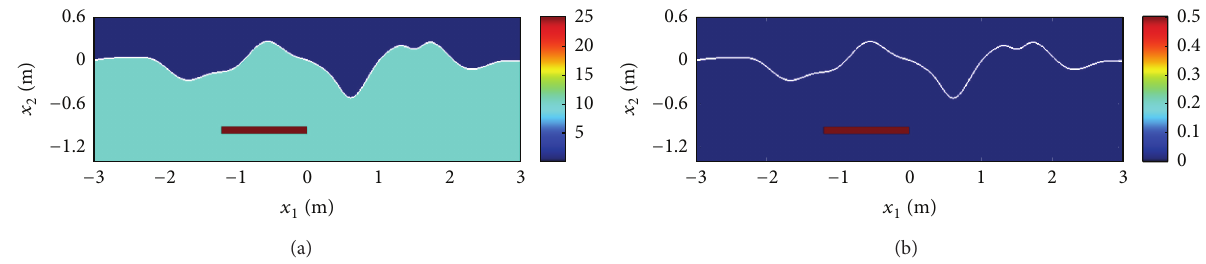
Figure 10: (a) The exact relative permittivity and (b) conductivity profiles of a thin bar and the lossy background.